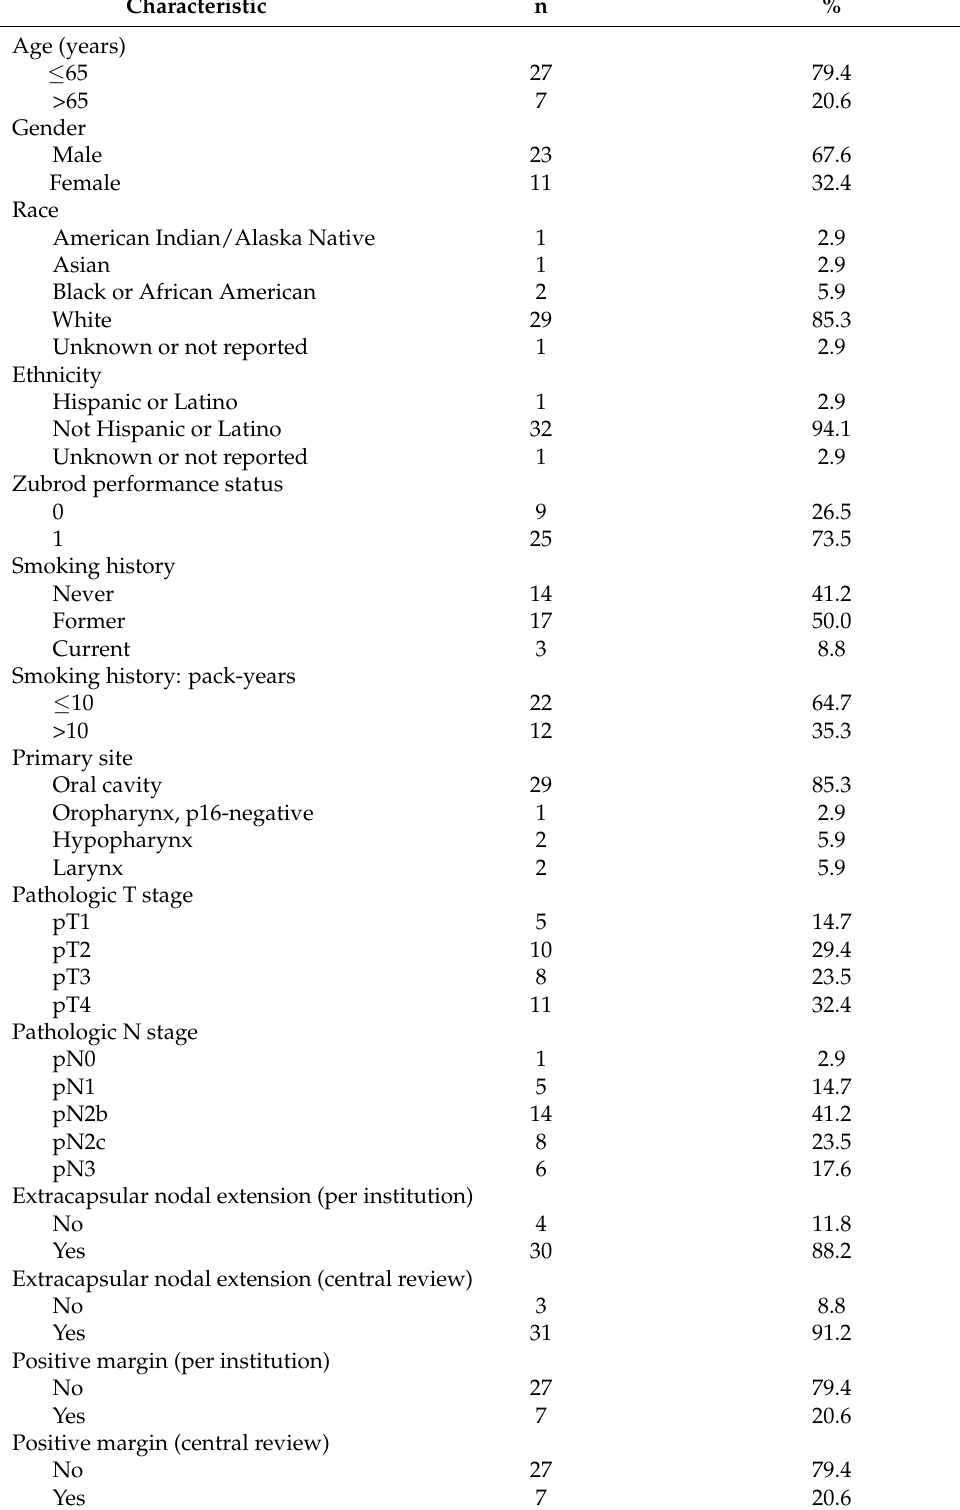
Table 2. Patient and Tumor Characteristics for Analyzable Patients in NRG-HN003 (n = 34).